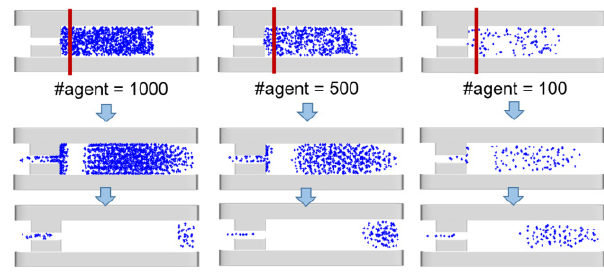
Fig. 1 Optimal evacuation route depends on not only the structure of the situation but also the distribution of people. Simulated agents (blue dots) evacuate to the left or right exit according to the guidance from a shortest path algorithm (weighted by road capacity). The division point (vertical red line) should be updated when the distribution of agents changes: if it is not, the agents do not reach the exits